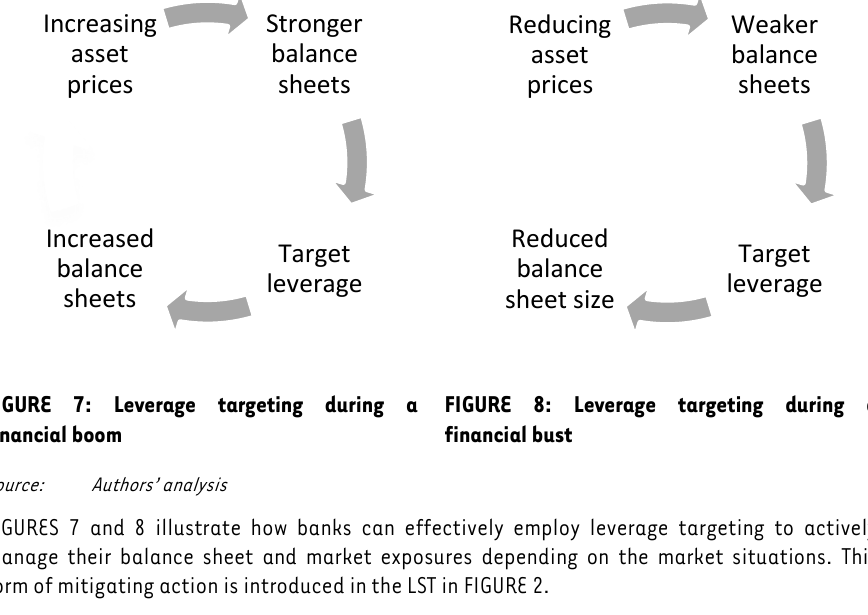
FIGURE 8: Leverage targeting during a financial